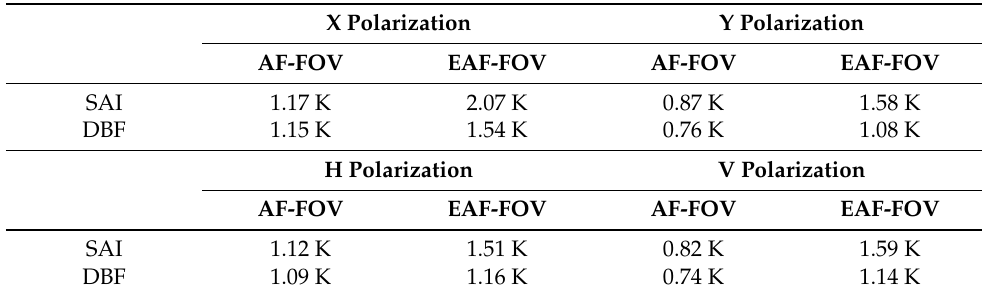
Table 1. Root mean square errors in the retrieved brightness temperature maps at instrument level in X and Y polarizations and at ground level in H and V polarizations.